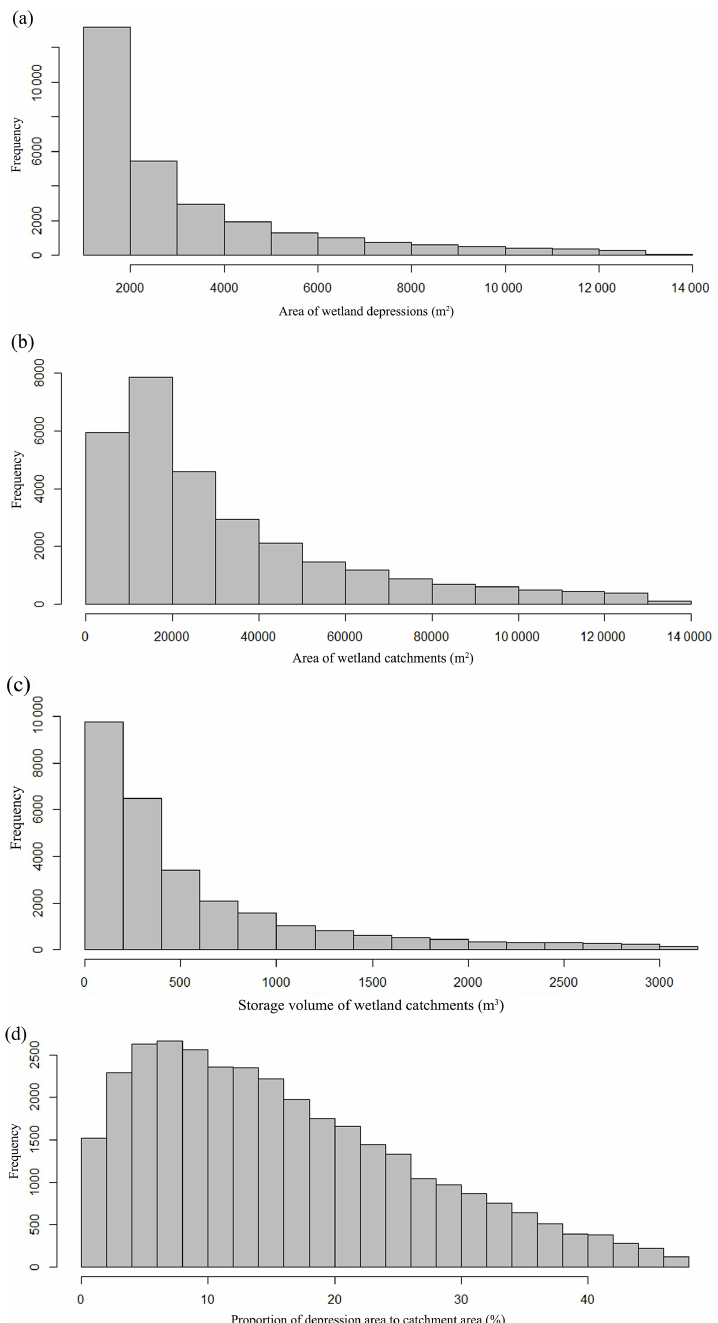
Figure 8. Histogram of wetland depressions and catchments. (a) Wetland depressions, (b) wetland catchments, (c) potential storage capacity, and (d) proportion of depression area to catchment